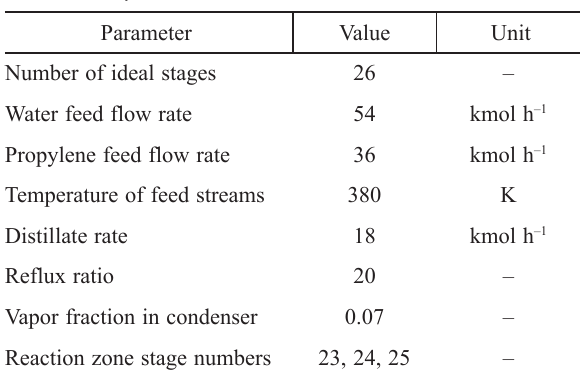
Table 2 – Values of design and operating parameters of RD system used in base case